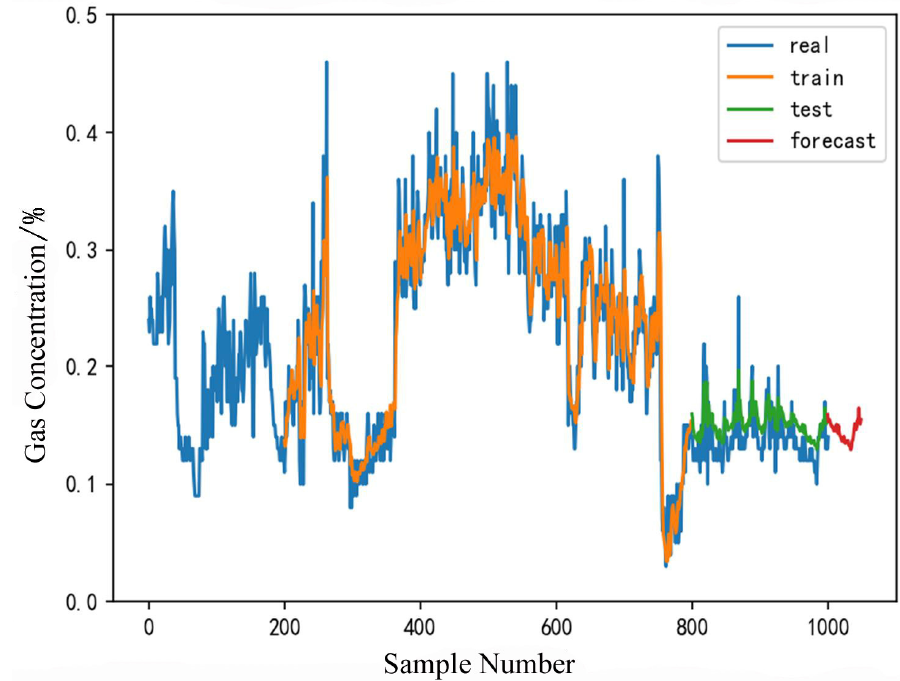
Figure 10. Pearson-LSTM prediction model fitting effect diagram.